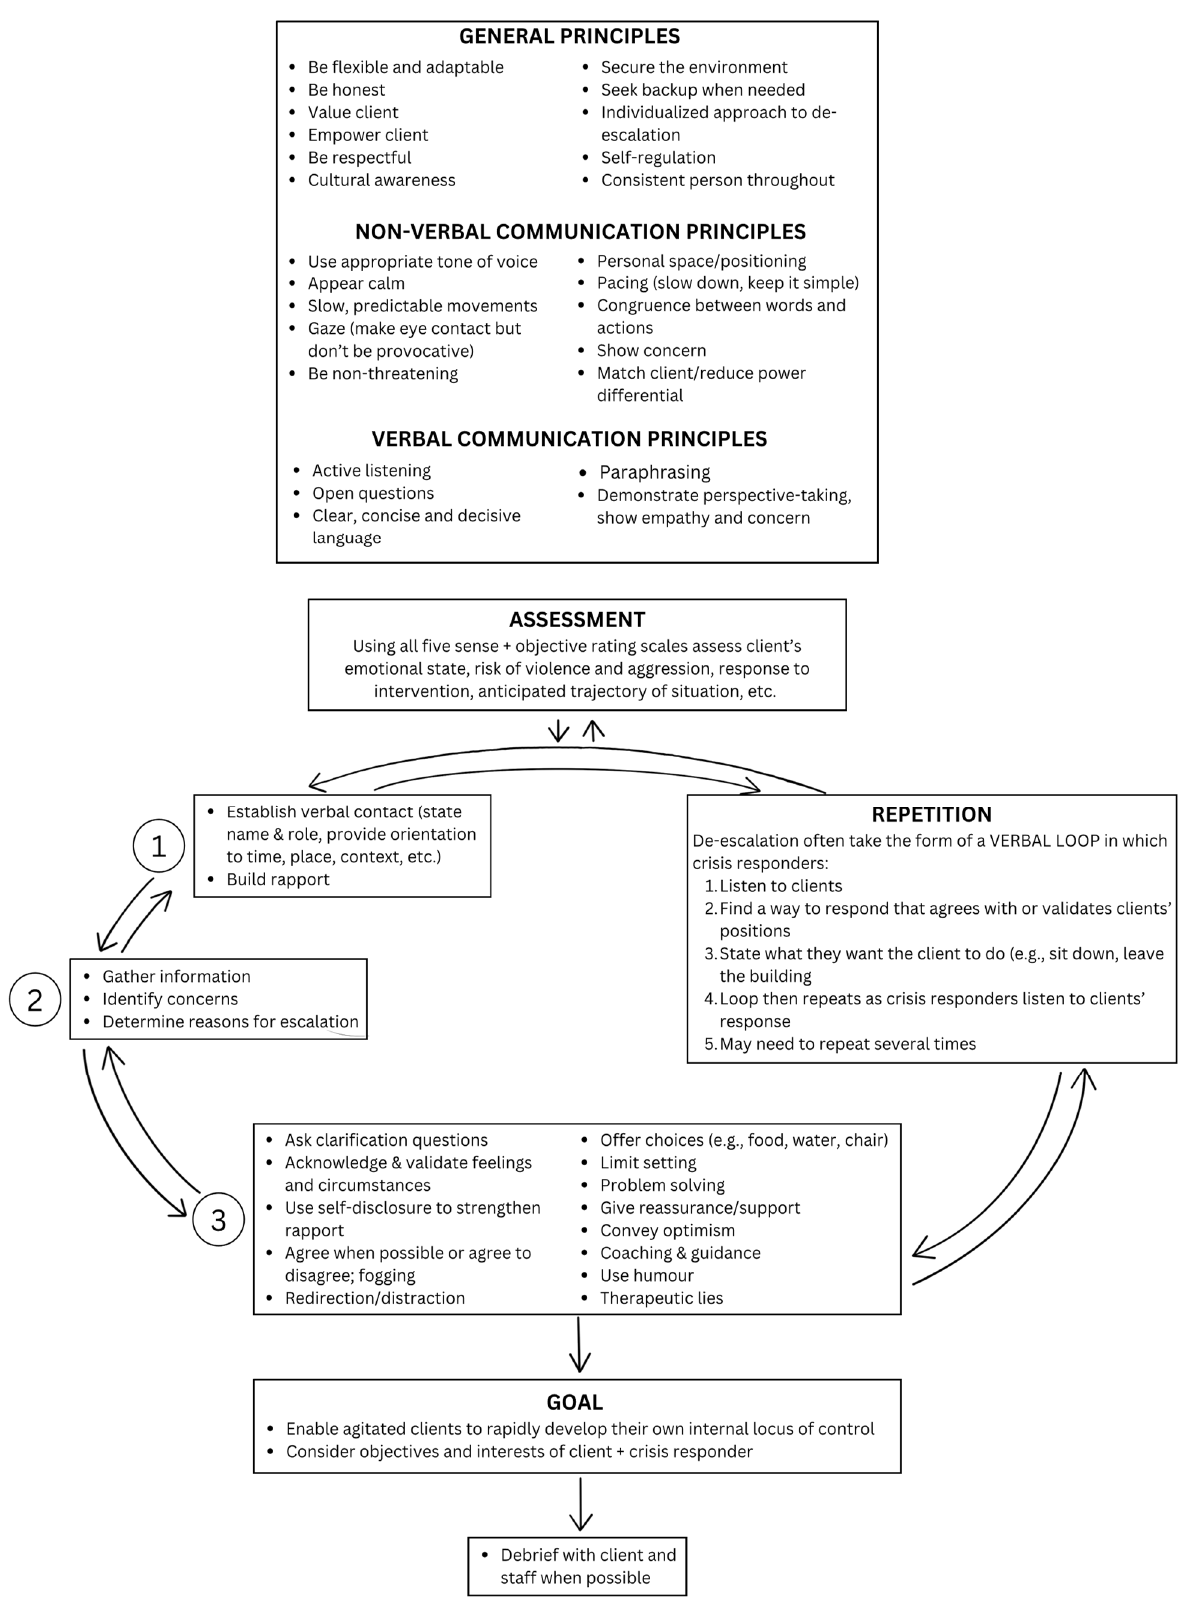
Figure 1. Working model of de-escalation to inform development of robot-assisted de-escalation practices.